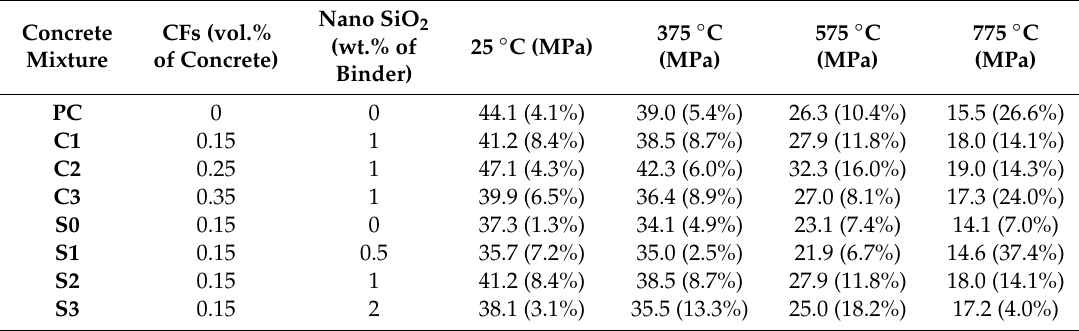
Table 4. Compressive strength of di ff erent NSCFRC after